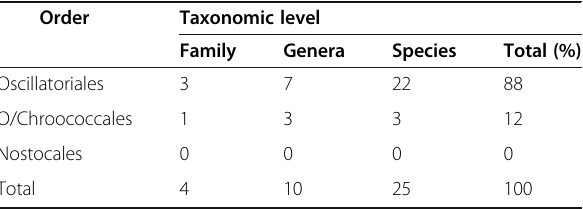
Table 4 Importance of taxonomic level of cyanobacteria in studied